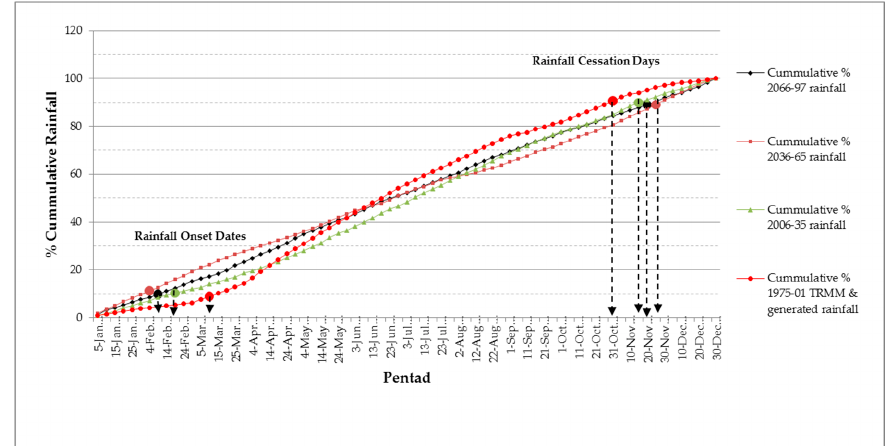
Figure 8. Kaabong Future Mean Rainfall Onset and Cessation Dates (TRMM rainfall (1975–2001) and